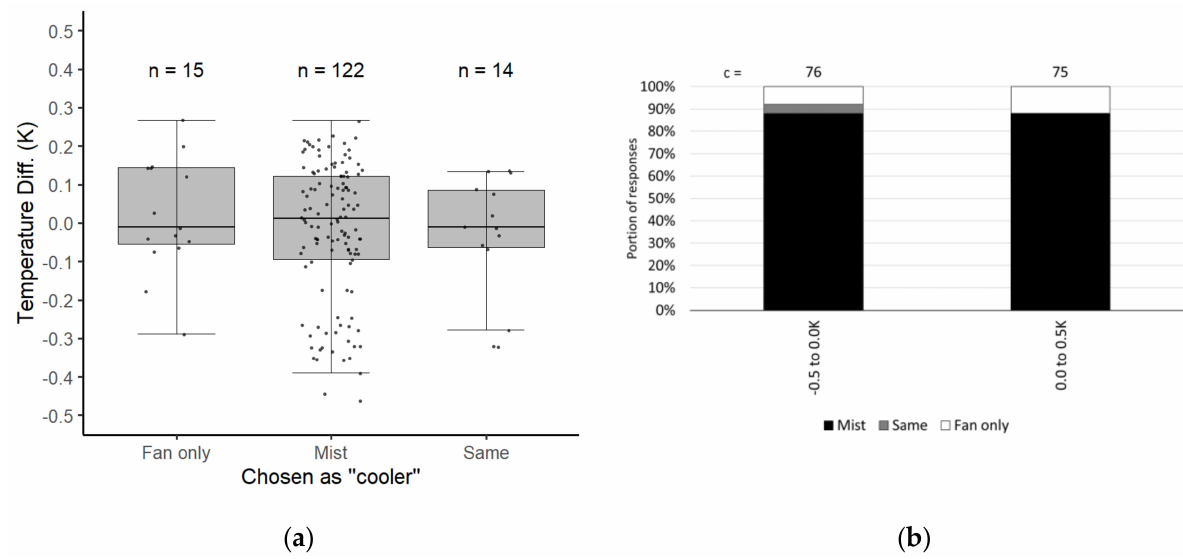
Figure 4. Distribution of temperature differences ( a ) and responses ( b ) from the first experiment